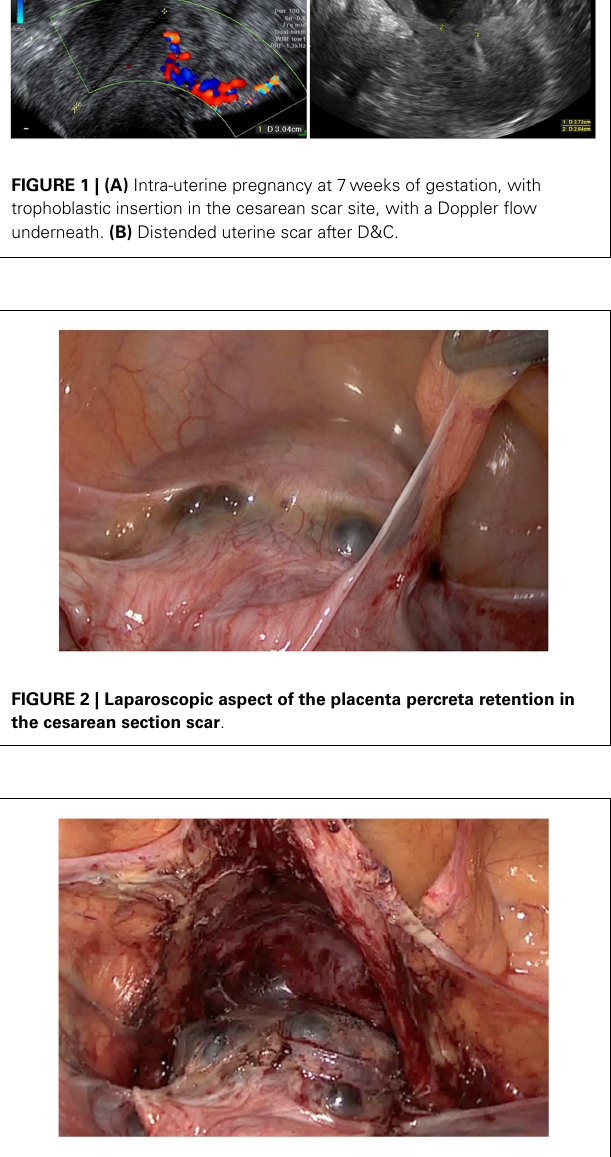
FIGURE 3 |Vesico uterine cleavage before hysterotomy .